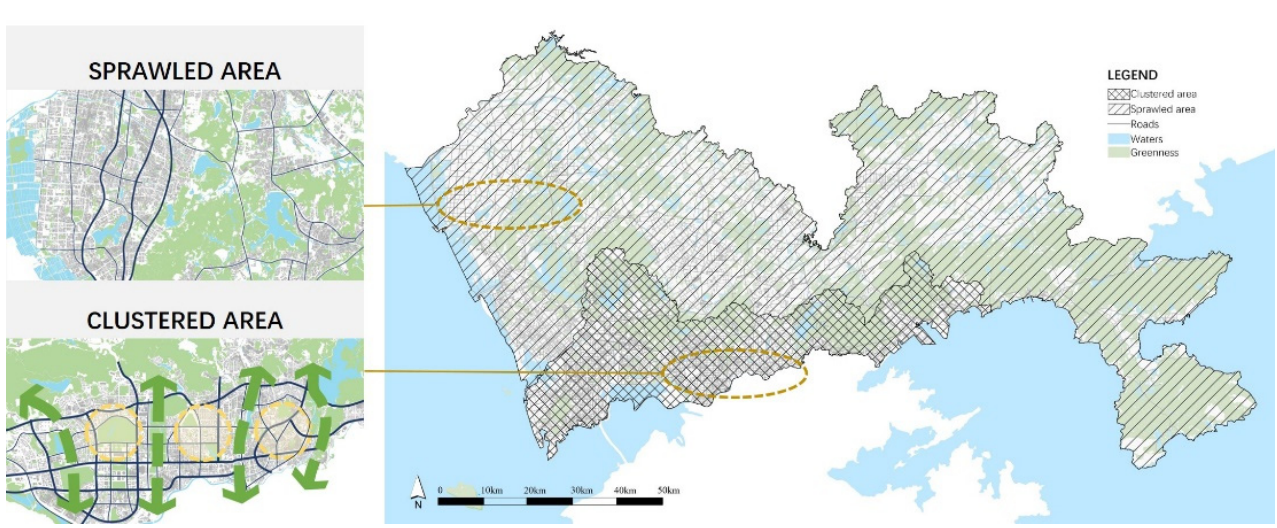
Figure 2. Schematic diagram of Shenzhen.